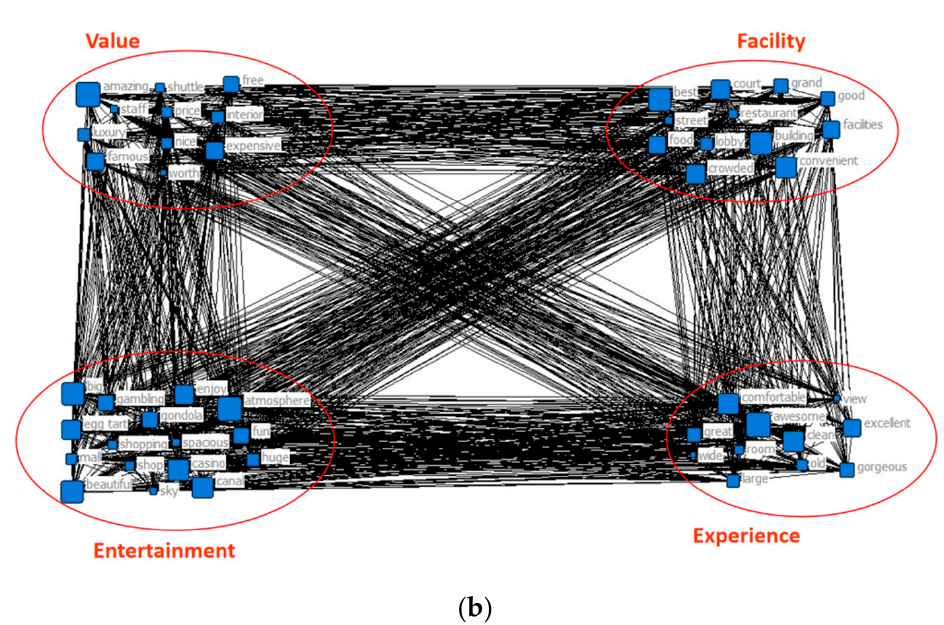
Figure 3. Visualization of CONvergence of iterated CORrelation (CONCOR) analysis. ( a ) The Venetian in Las Vegas; ( b ) The Venetian Hotel in Macao.